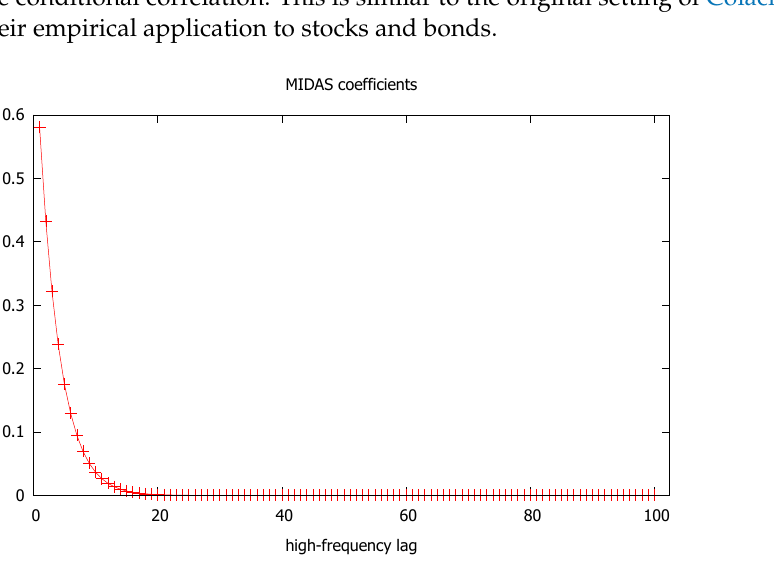
Figure A1. MIDAS lags for the baseline